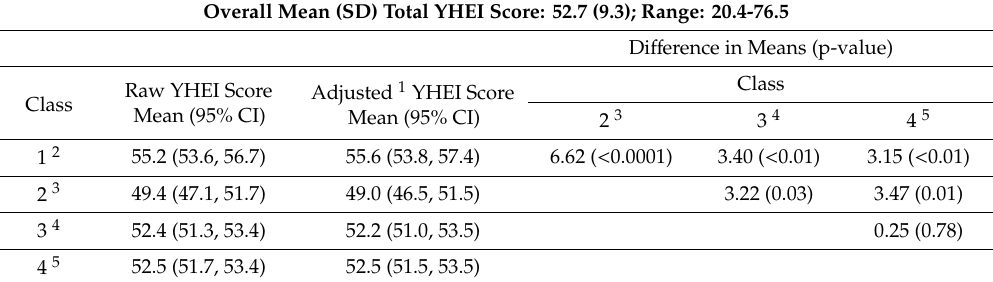
Table 3. Comparison of raw and adjusted 1 mean total YHEI scores between latent classes among 969 Project Viva